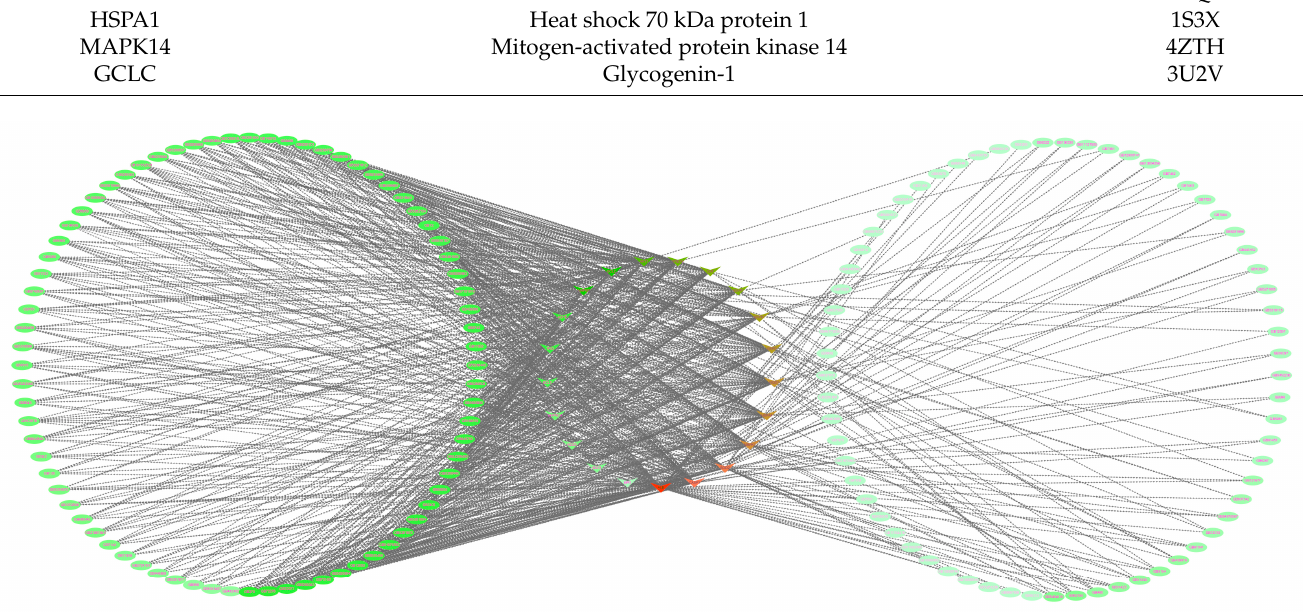
Figure 4. Network chart of compound-target protein in compounds in EGb.